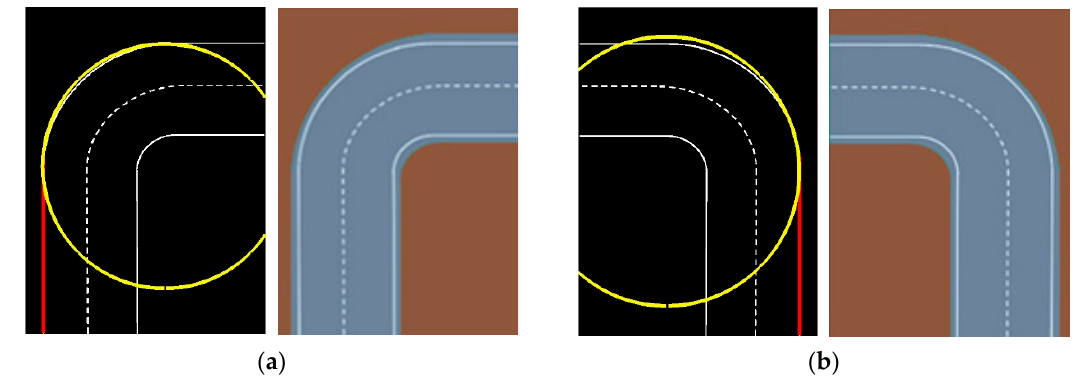
Figure 9. The road turning with the circle shape ( a ) right turning ( b ) left turning.